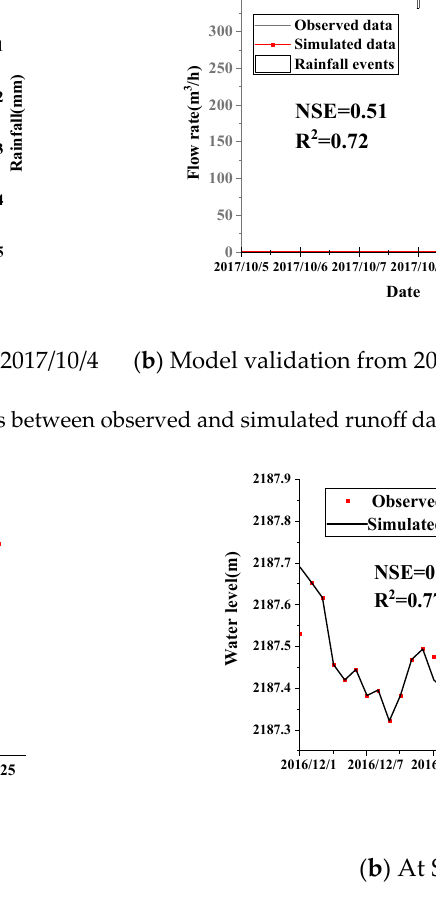
Figure 7. Comparisons between observed and simulated water levels at Stations M2 and M3 in the Huangshui River.